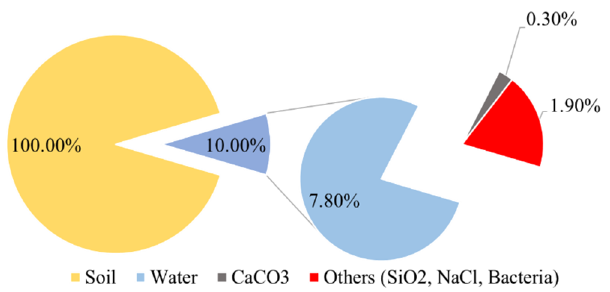
Figure 14. Proportion of CaCO 3 in